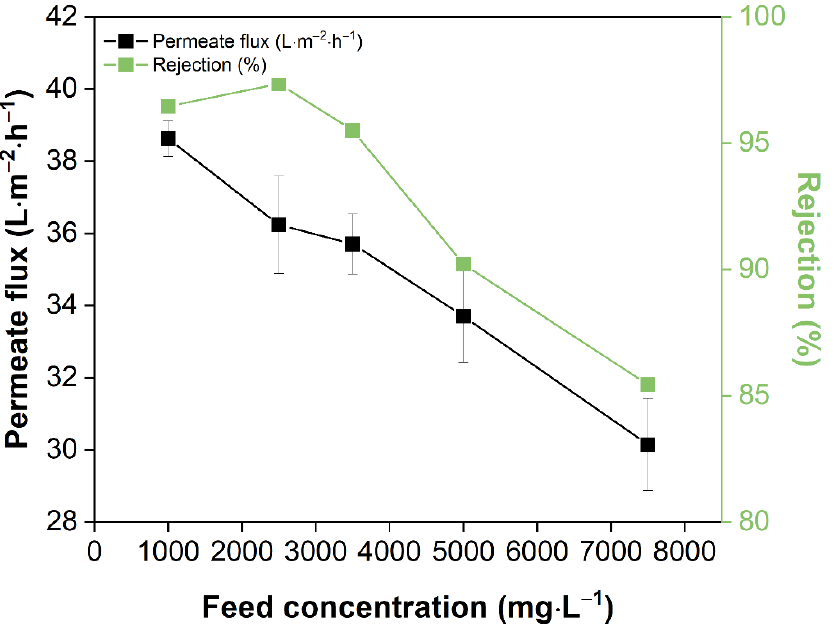
Figure 4. Permeate flux (black dot line) and rejection (green dot line) of RO membrane after 10 h running under different feed concentrations from 1500 to 7500 mg · L − 1 . Operating conditions: feed solution, Na 2 SO 4 ; feed flow rate, 35 L · h − 1 ; operating pressure 0.5 MPa; temperature, 18 ◦ C; pH,